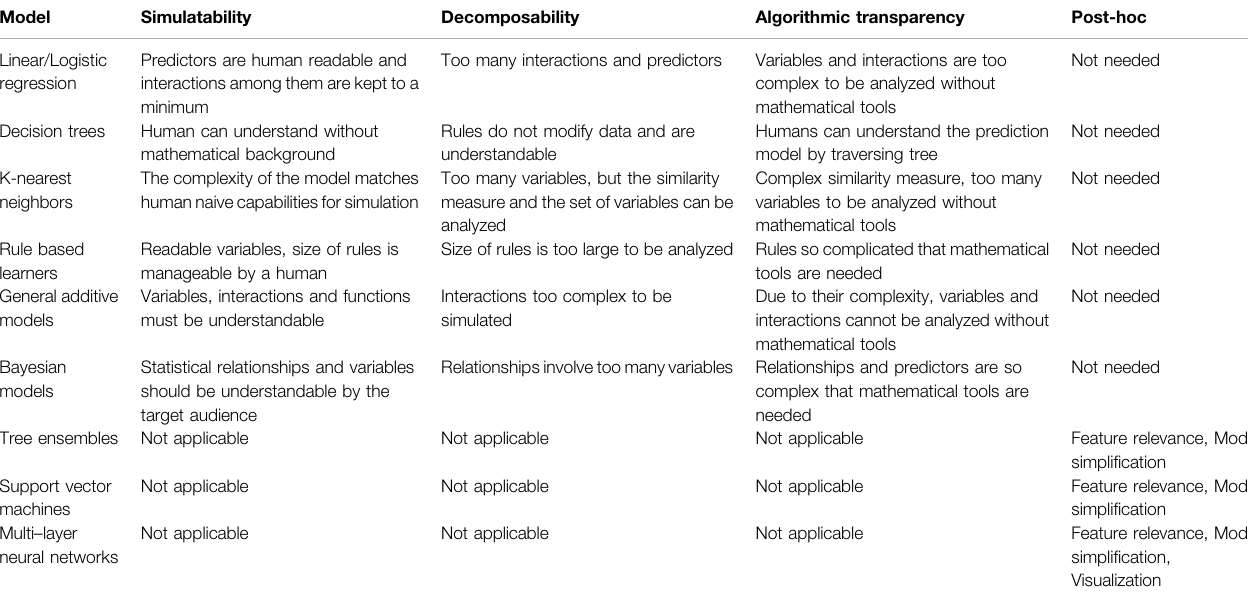
TABLE 1 | Comparing models on the kinds of transparency that are